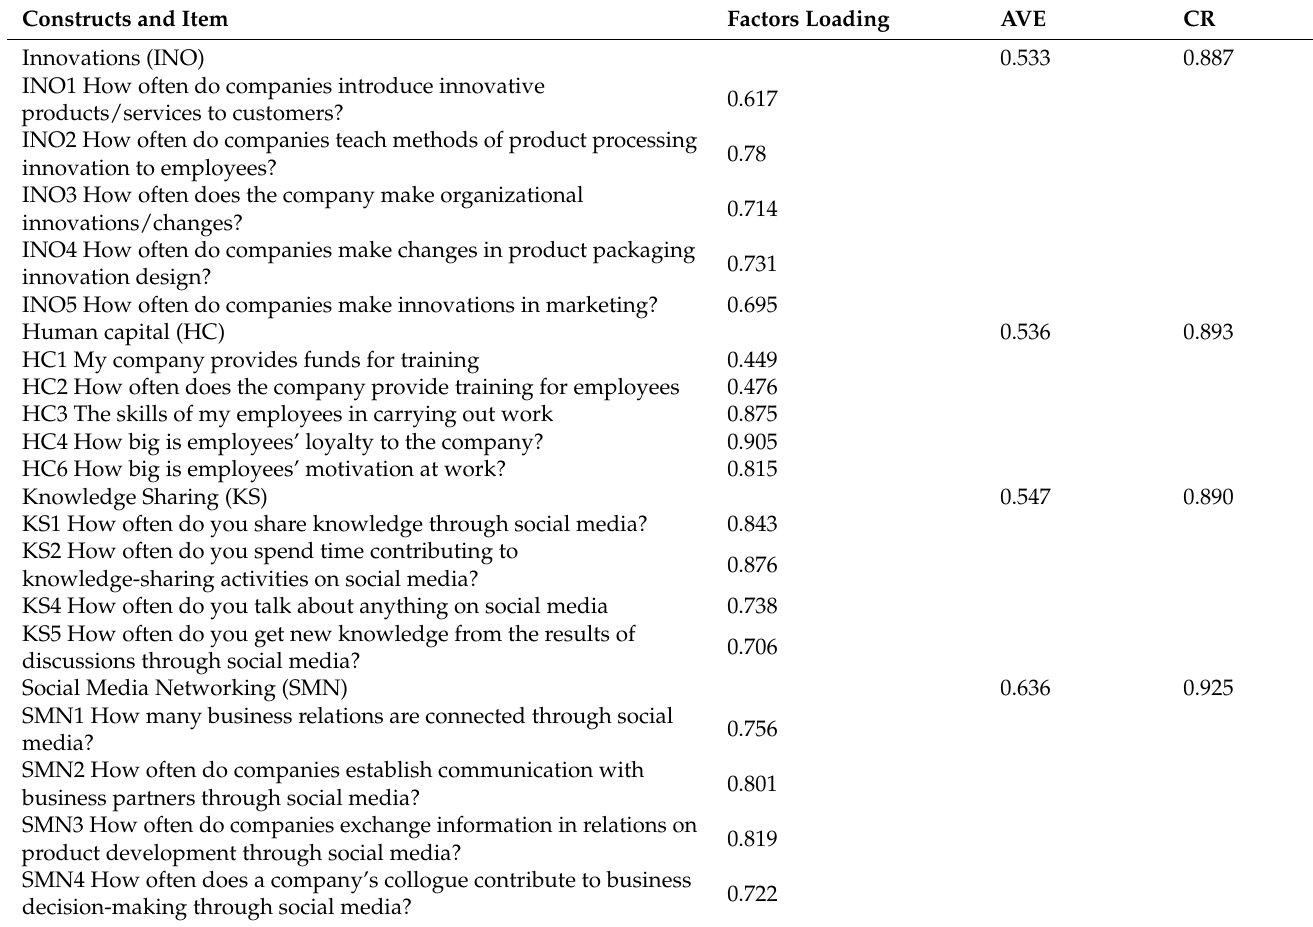
Table 2. CFA Test Results.